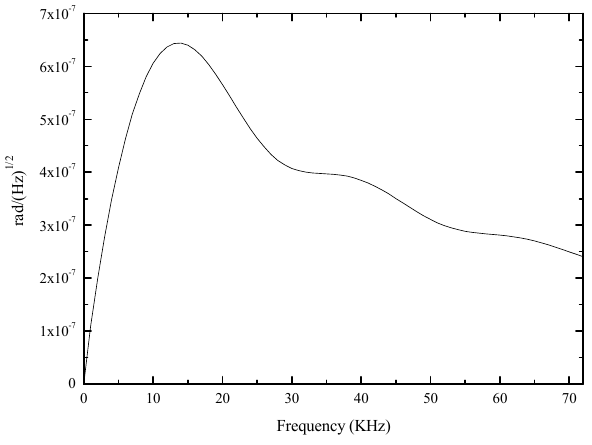
Figure 7. The phase noise spectral density as a function of frequency.